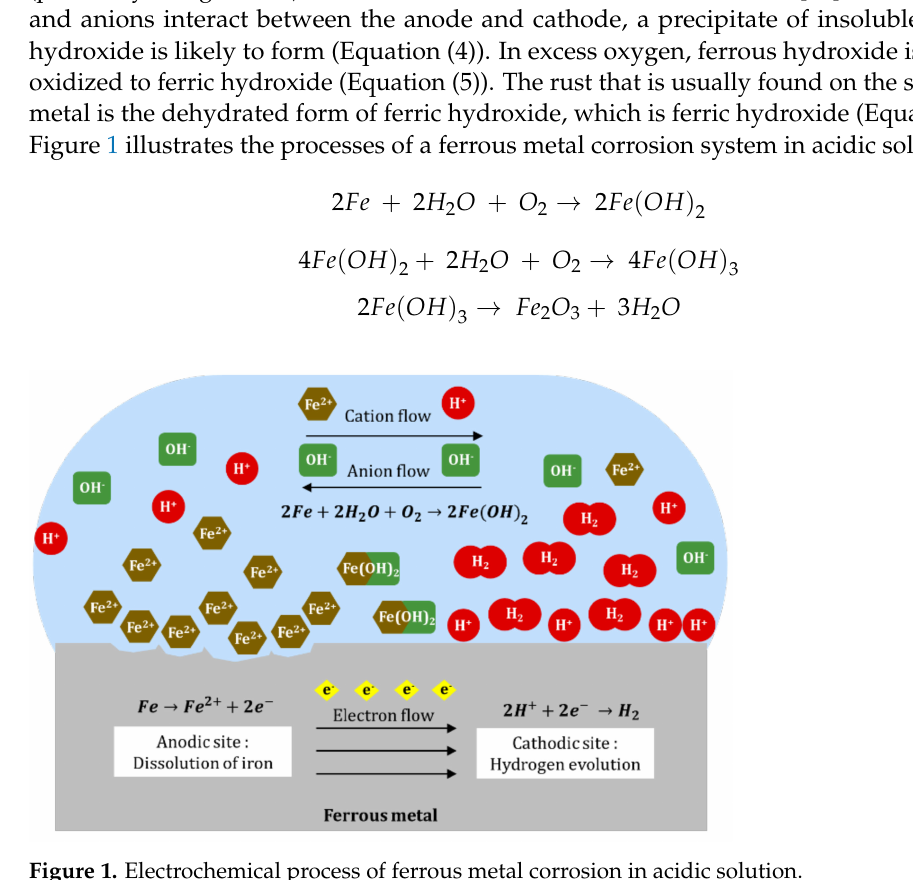
Figure 1. Electrochemical process of ferrous metal corrosion in acidic